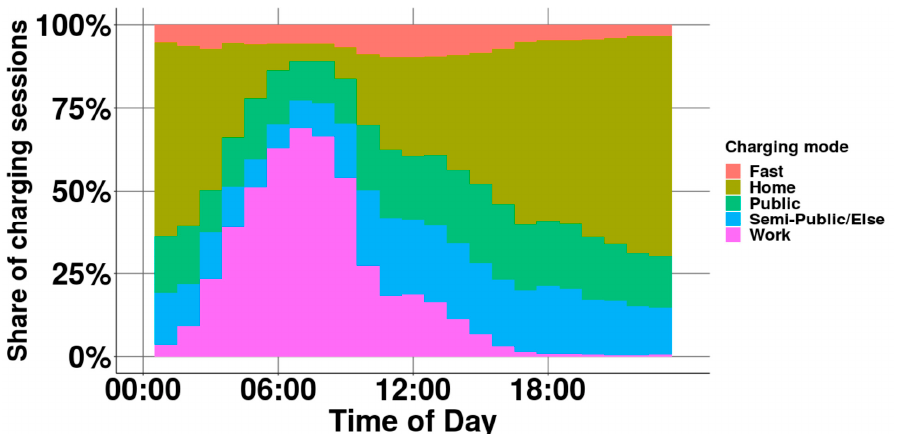
Figure 3. Share of charging sessions across charging during the day.